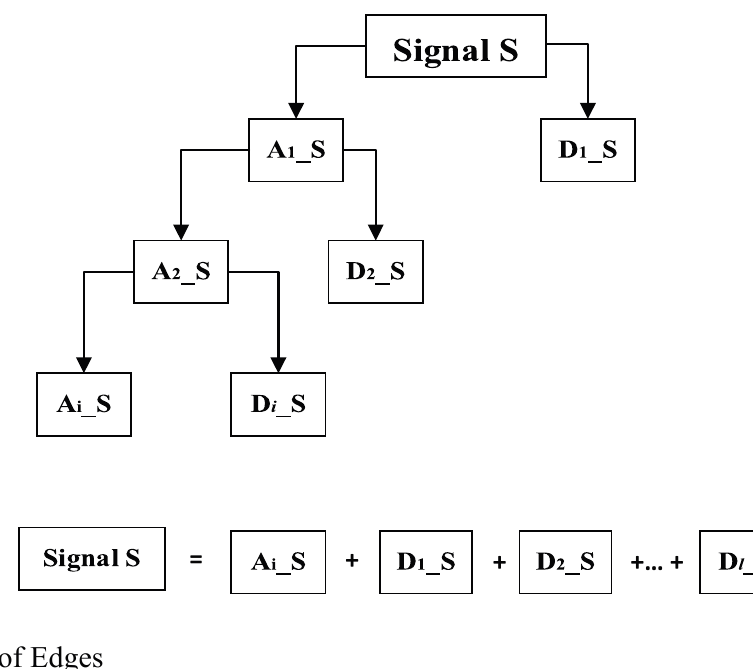
Figure 5. Scheme of signal reconstruction from approximation (A) and details